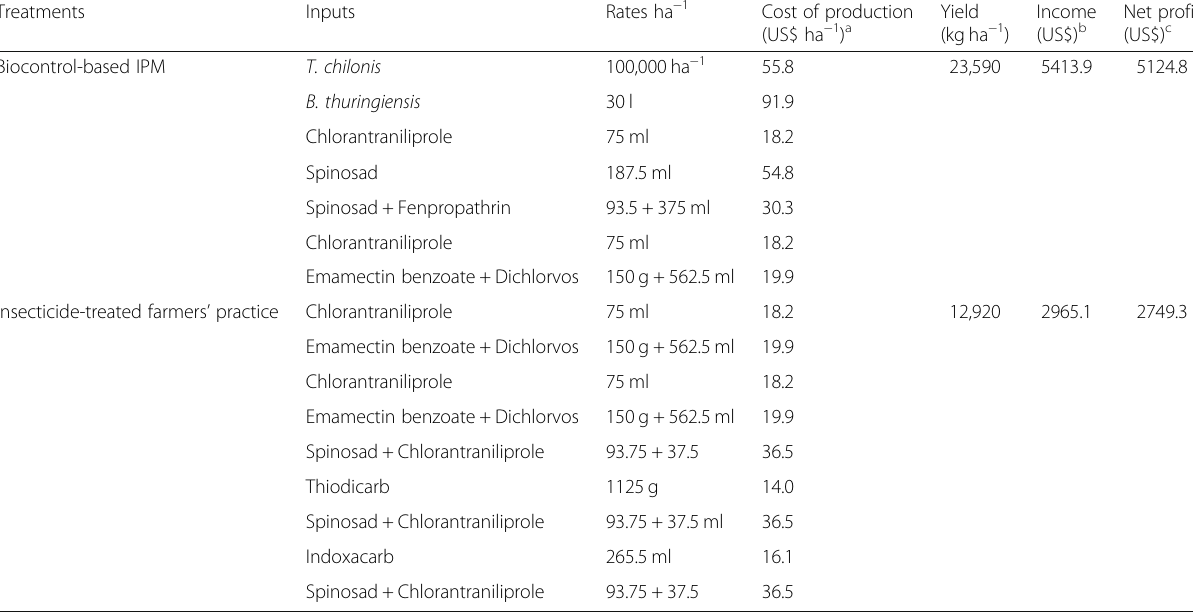
Table 2 Cost-benefit of biocontrol-based IPM practices and insecticide-treated farmers ’ practice for controlling DBM in cabbage